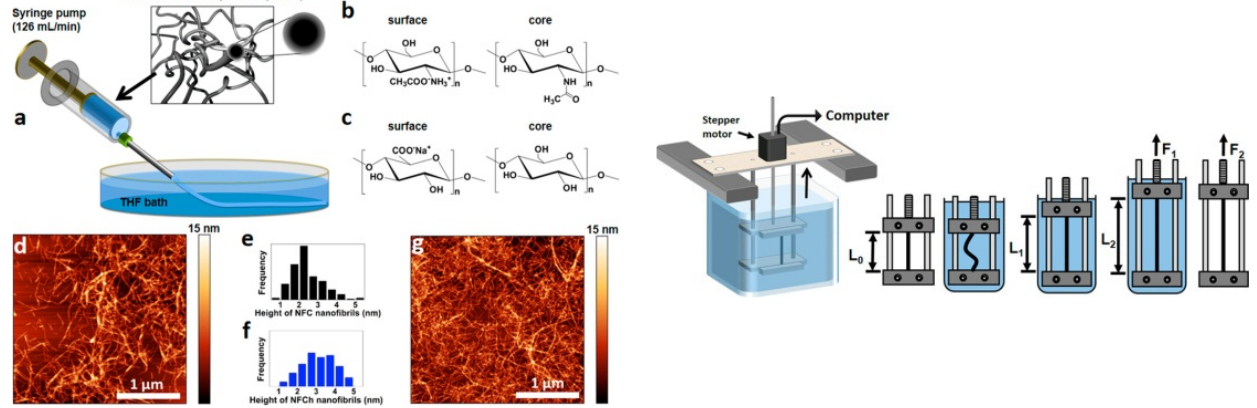
Figure 9. ( left ) Wet spinning of CNFs. ( a ) Wet-spinning setup using controlled extrusion with a syringe pump into a THF coagulation bath using NFC and NFCh dispersions, containing surface modifications as depicted in ( b ) and ( c ). ( d – g ) AFM height images for NFC ( d ) and NFCh ( g ), as well as their corresponding image analysis concerning the average height of 200 nanofibrils for each class of nanoparticle (( e ) = NFC; ( f ) = NFCh); ( right ) schematic drawing for the computer-controlled wet-stretching device into which a fiber can be clamped and immersed into a liquid and stretched using controlled strain rates (reprinted with permission from Torres-Rendon, J.G.; Schacher, F.H.; Ifuku, S.; Walther, A. Mechanical performance of macrofibers of cellulose and chitin nanofibrils aligned by wet-stretching: A critical comparison. Biomacromolecules 2014 , 15 , 2709–2717. Copyright 2014, American Chemical Society).